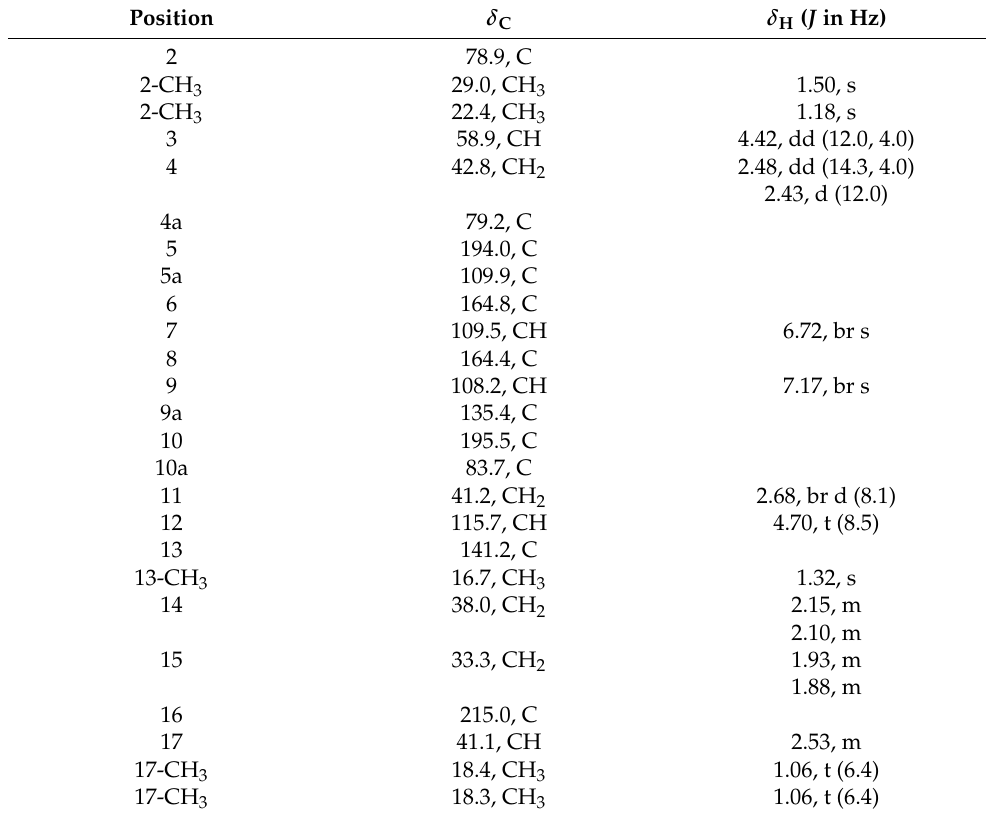
Table 1. 1 H (700 MHz) and 13 C (175 MHz) NMR data of compound 1 in CDCl 3